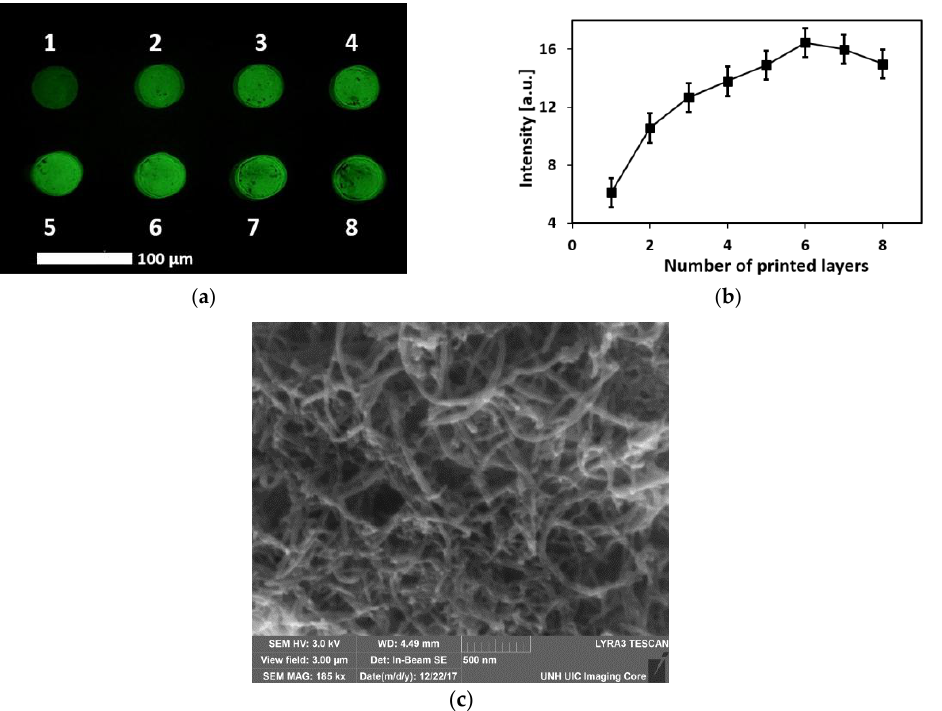
Figure 3. ( a ) Fluorescence image of the printed CNT-aptamer ink in a single-droplet array with different numbers of layers (as indicated by the numbers in the image); and ( b ) the intensity profile of the printed circles versus the number of layers. Each droplet has a diameter of 40 µm; ( c ) shows an SEM image of the CNT-aptamer ink used for lysozyme recognition.